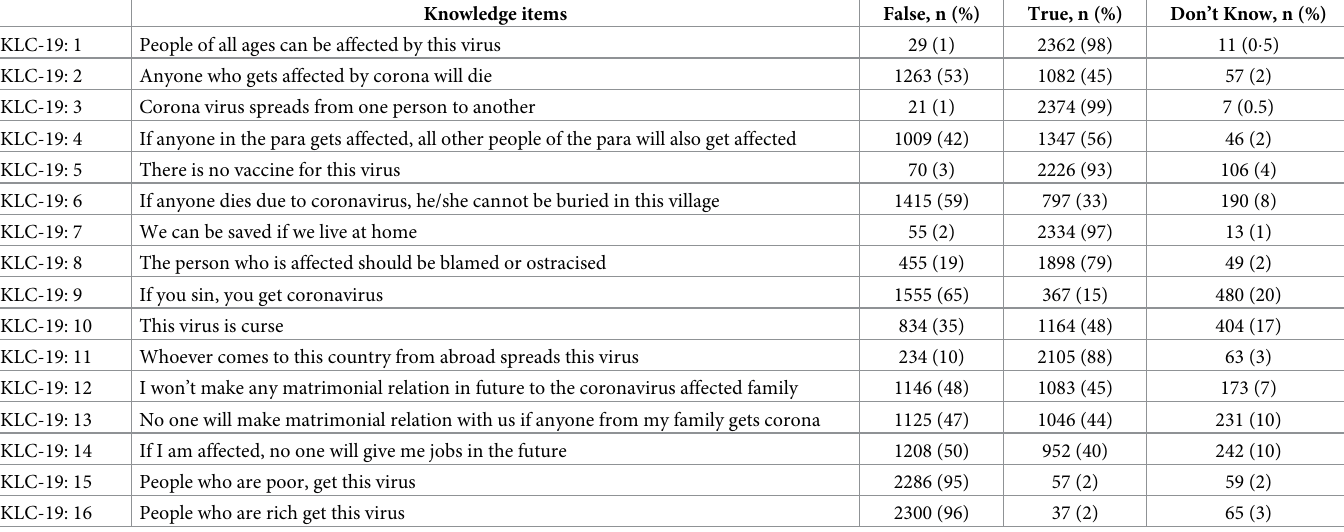
Table 1. Frequency of the statement related with knowledge level on COVID-19 (KLC-19). Knowledge items False, n (%) True, n (%) Don’t Know, n